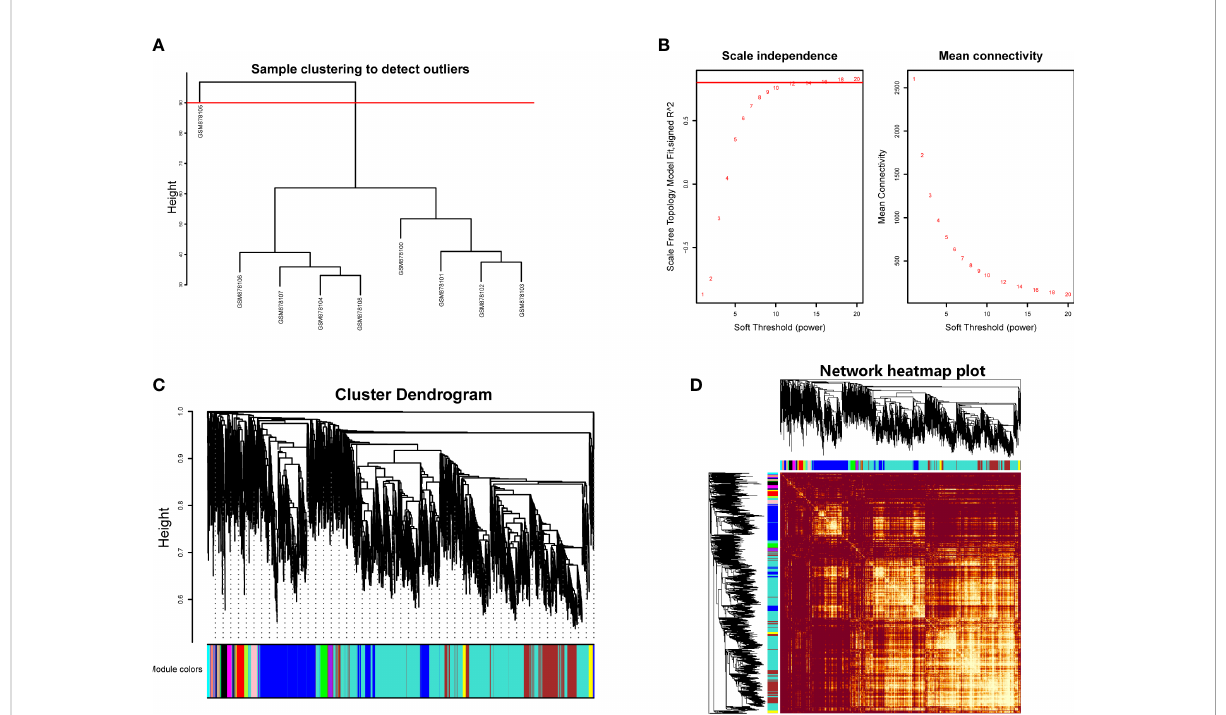
FIGURE 1 (A) Hierarchical clustering analysis to detect outliers in GSE35958. (B) Determination of soft threshold power value. Left panel represented scale-free model fi t index of different values; right panel showed the mean connectivity of these values. (C) Dendrogram branch plot of genes based on dissimilarity measure and assignment modules. (D) Topological overlap measure heatmap of the weighted co-expression network. Light area indicated highly clustered